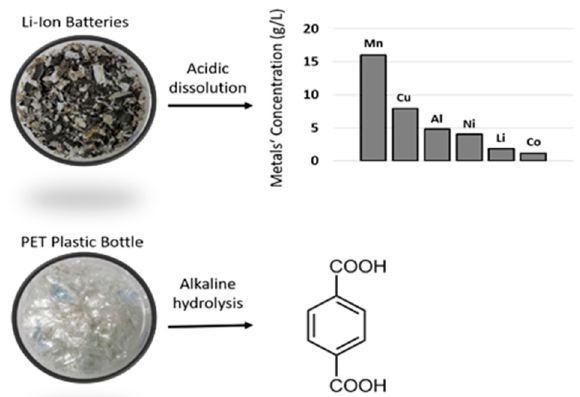
Figure 1. Dissolution of Li-ion batteries (top) and alkaline hydrolysis of plastic bottles (bottom).